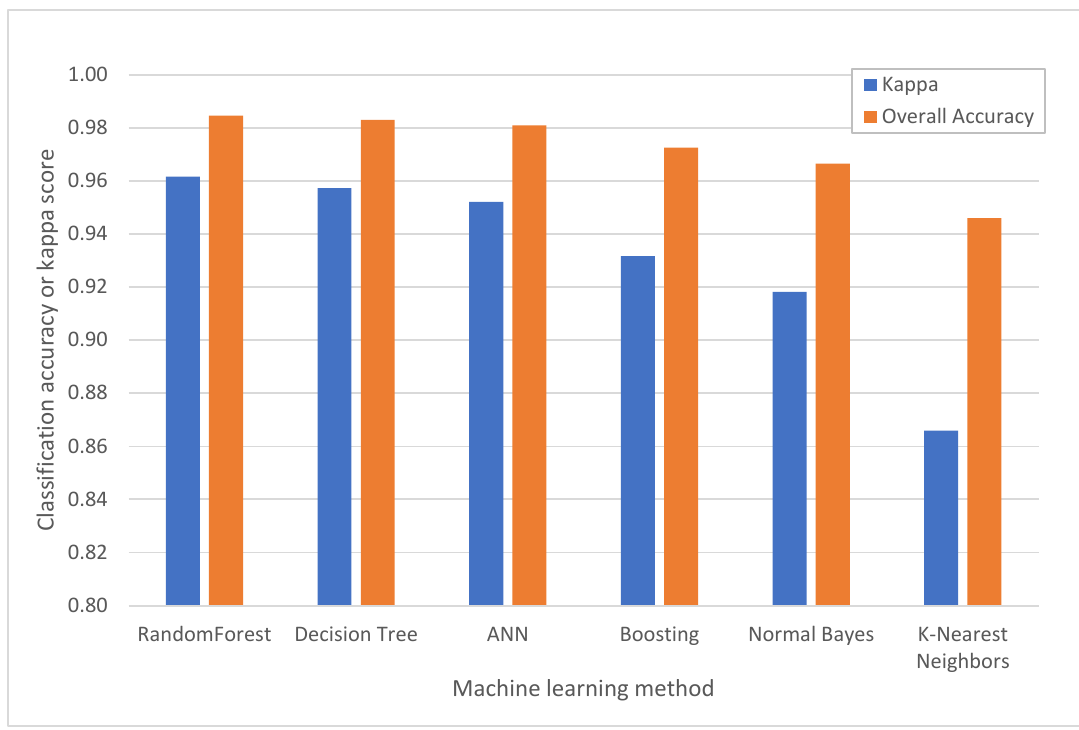
Figure 4. Model accuracy for identifying terraces using the best performing subset of five terrain attributes.